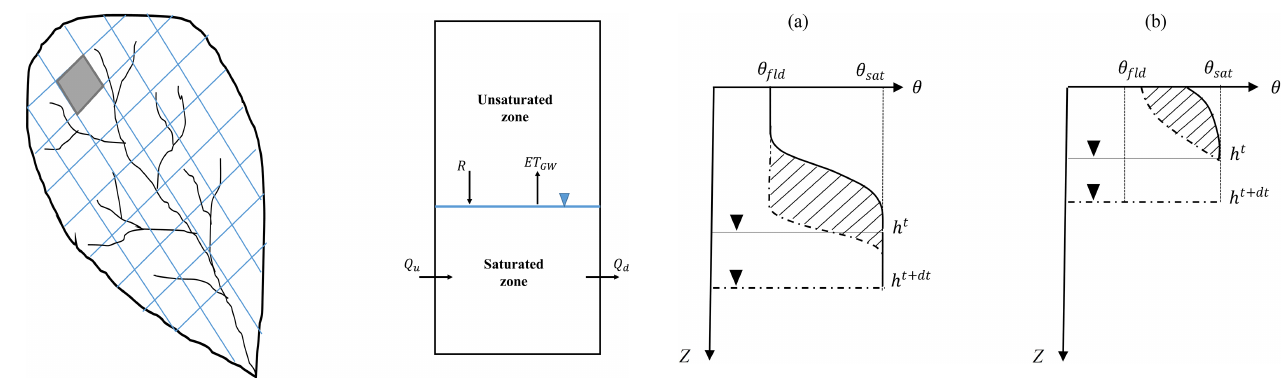
Figure 1. Schematic view of computational grids in a catchment and corresponding input and output fluxes over the saturated zone.